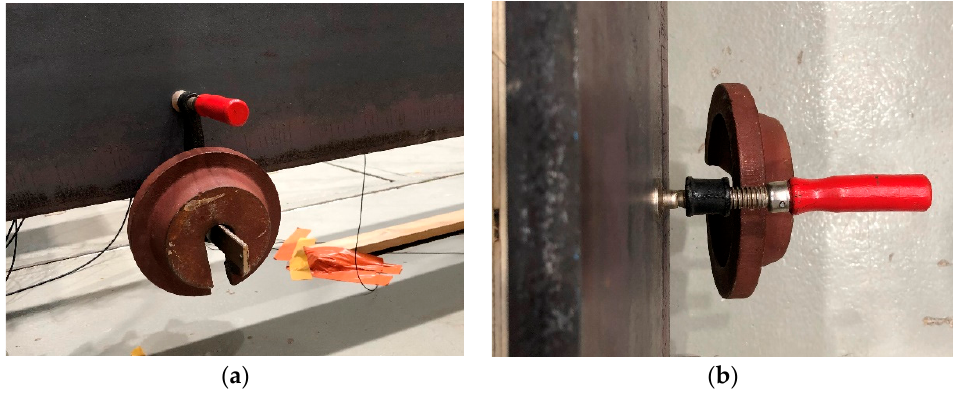
Figure 11. Mass placement. ( a ) front view, ( b ) side view.